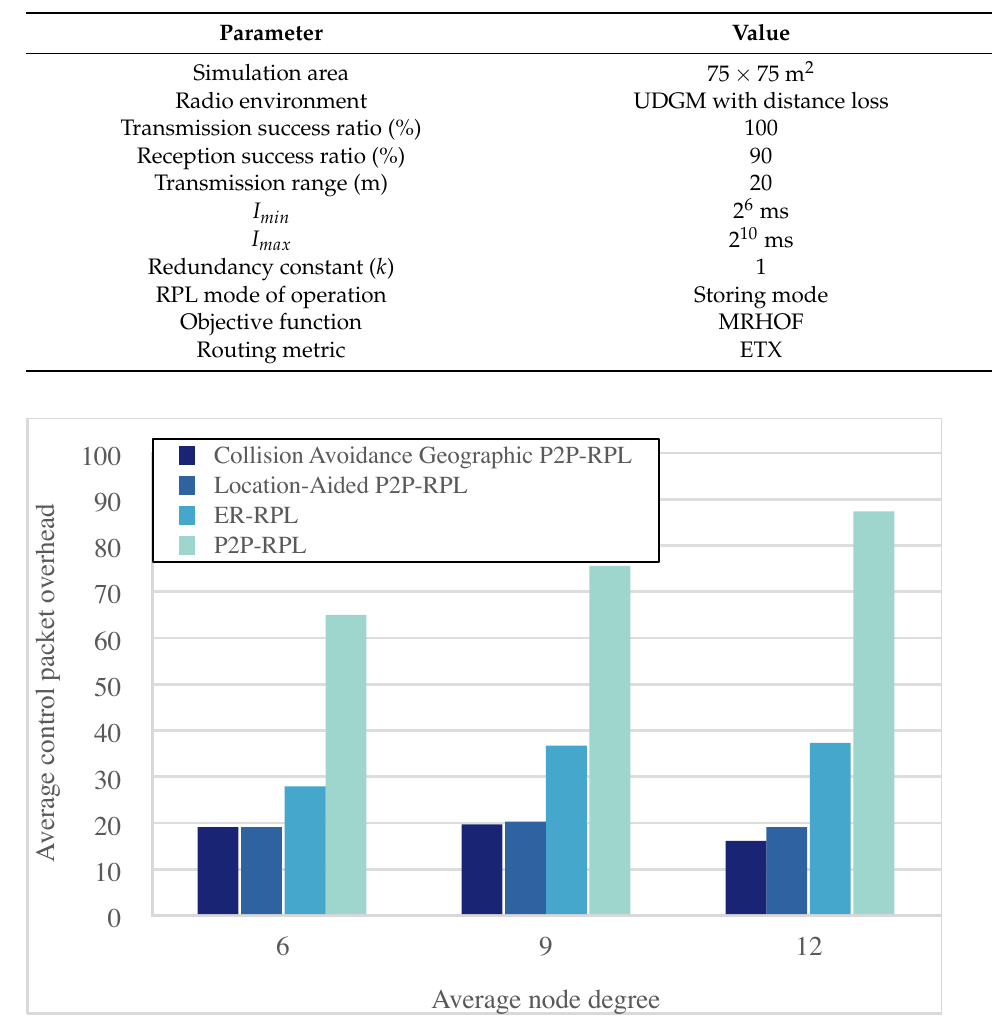
Table 3. The simulation model parameters.